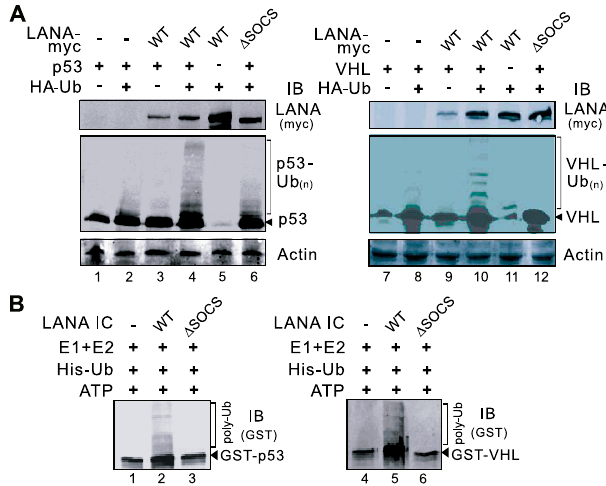
Figure 7. LANA Promotes Polyubiquitylation of Tumor Suppressors p53 and VHL (A) LANA induces p53 and VHL polyubiquitylation. Saos-2 (left panel) or 786-O (right panel) cells were cotransfected with different combinations of myc-LANA (WT and D SOCS), myc- p53 (or HA-VHL), and HA-Ub as indicated. At 48 h posttransfection, transfected cells were harvested, lysed, and protein normalized. Total protein (40 l g) was subjected to resolve and IB assays against myc (LANA), p53 (or VHL ), and b -actin. The data showed LANA can induce p53 and VHL ubiquitylation in vivo. (B) The LANA–Elongin BC–Cul5–Rbx1 complex induces p53 and VHL polyubiquitylation in vitro. The cell lysates of WT LANA (Figure 3C, lane 4) or SOCS-box–like motif deletion mutant (Figure 3C, lane 3) as control was subjected to anti-myc immunoaffinity purification. The purified LANA immune complex (IC) was incubated with various combinations of Uba1 (E1), Ubc5a (E2), His-Ub, or GST-VHL (or GST-p53) in the presence of ATP in vitro. The proteins were separated by SDS-PAGE and IB against GST antibody. Left panel, GST-p53; right panel, GST-VHL. DOI: 10.1371/journal.ppat.0020116.g007